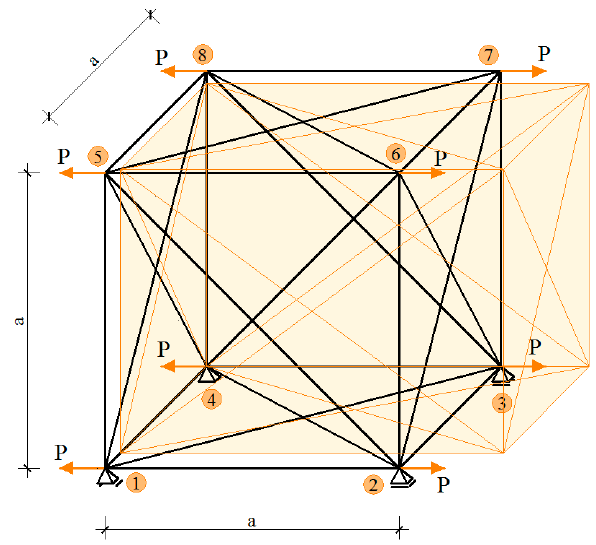
Figure A2. State σ y = const —a deformed structure